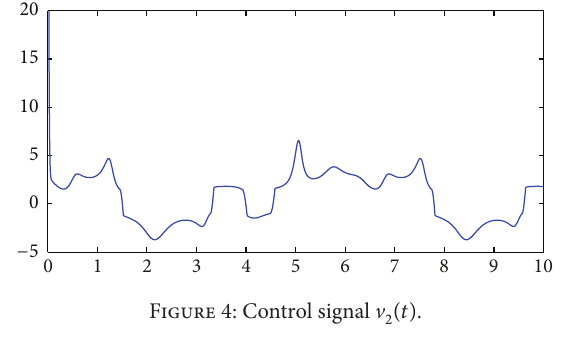
Figure 4: Control signal V 2 (𝑡)